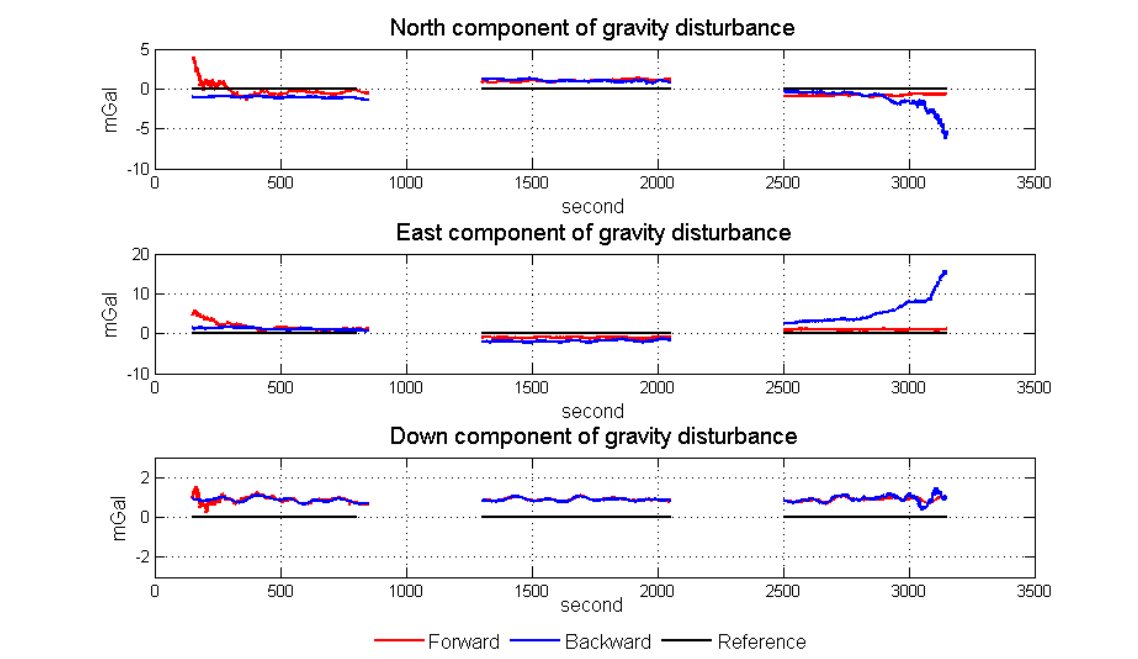
Figure 7. Gravity disturbance vector simulation results after error